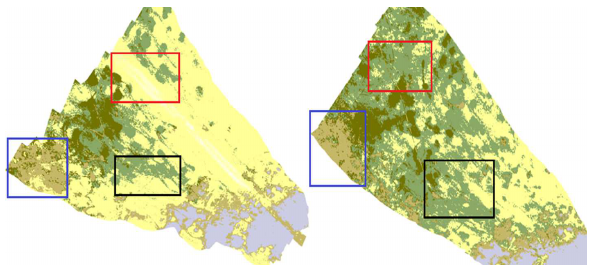
available reference data namely (i) Yellow Sand, (ii) Sand and Algae, (iii) Mud Sand and Corals, (iv) Sand and (v) Gravel.